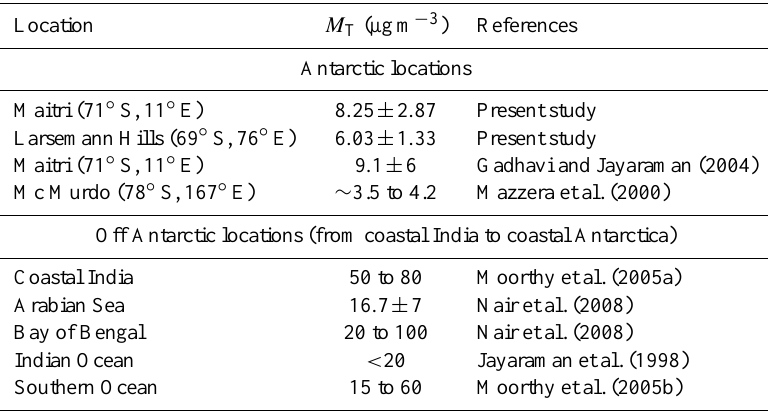
Table 3. Total mass concentration at Antarctic location and comparison with the off Antarctic coastal and oceanic regions from coastal India to coastal Antarctica.